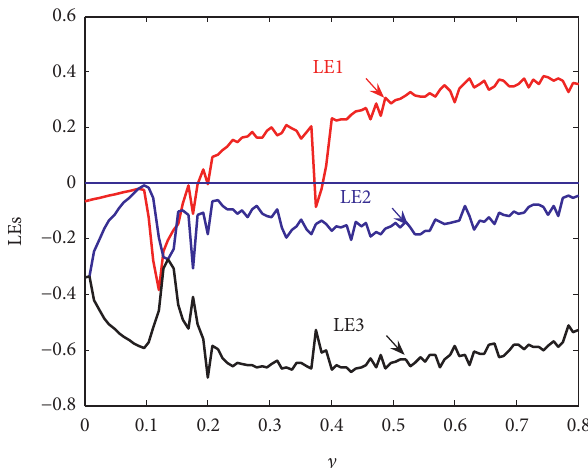
Figure 16: x – y phase diagram which denotes that the system is periodic when β � 1.2.